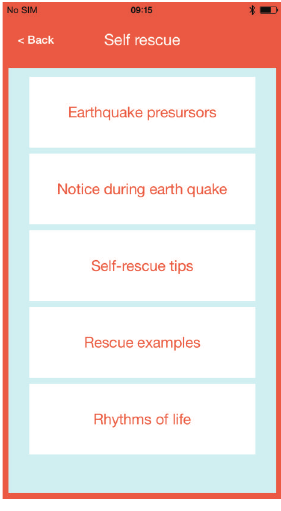
Figure 2: Self-rescue knowledge after